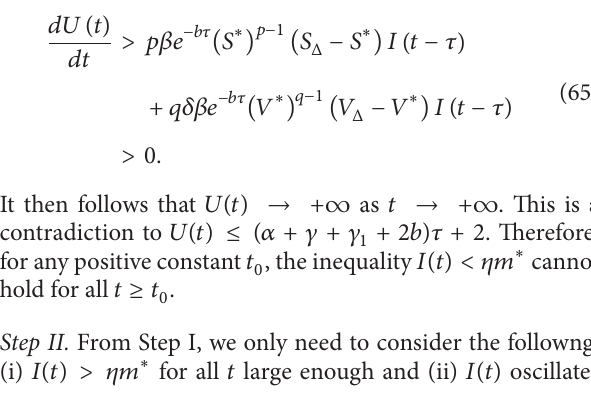
Then from the second equation of (4) and (37), we easily see